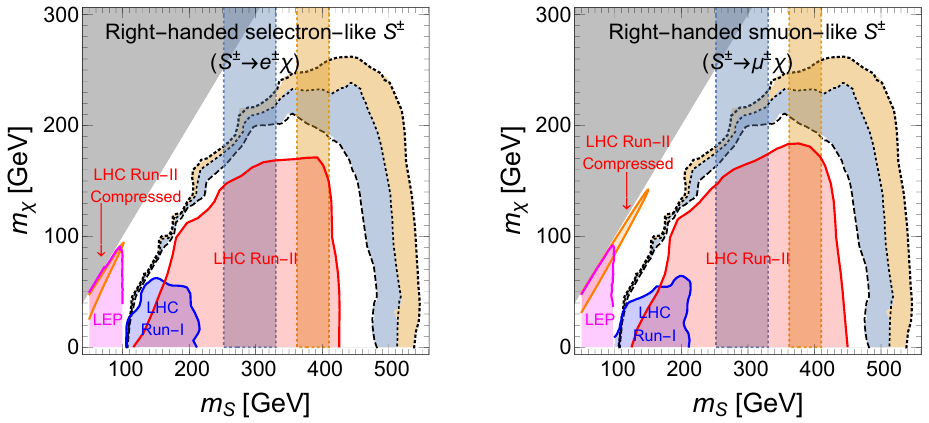
Figure 14 . The interplay between gravitational wave detection and LHC searches. The collider constrains and projections are the same as those in figure 3. The light blue (orange) shaded region corresponds to λ = 2 (3), with the vertical boxed boundary regions being the LISA-detectable HS parameter space, while the irregular boundary regions being enhanced part of the LHC projections when including the gg → h ∗ → S + S − contribution.